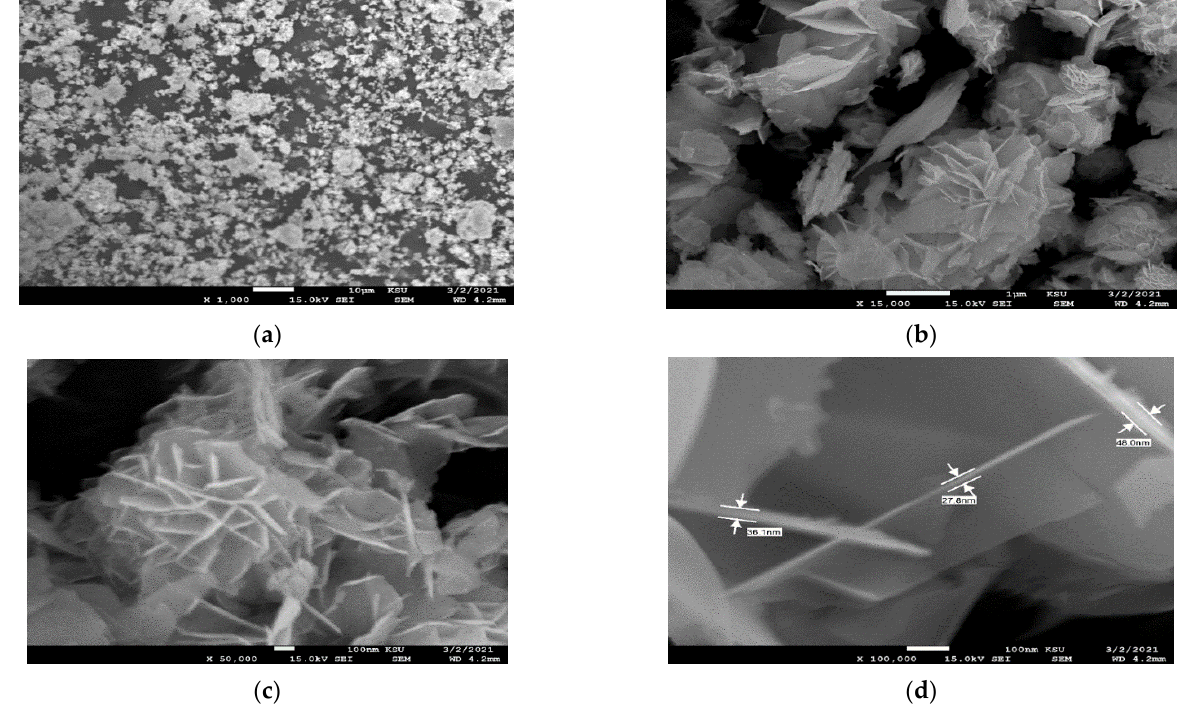
Figure 1. ( a – d ) The SEM results for the BiOI nanosheets synthesized by sonochemical method at room temperature.